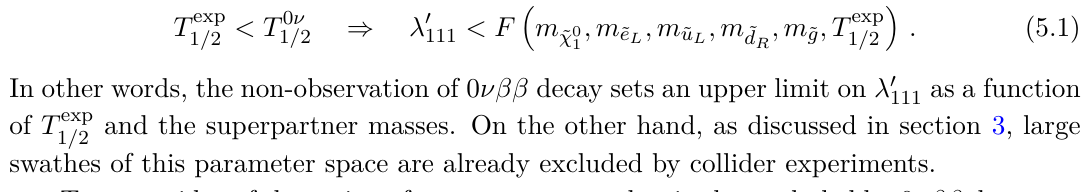
, m ) plane excluded by colliders and the non- ˜ χ 0 1 111 ≥ T 0 ν . The colours indicate the η term that 1 / 2 1 / 2 , m ) saturating ˜ χ 0 1 111 1 / 2